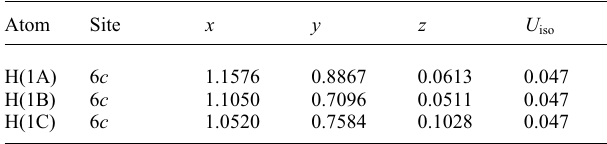
Table 2. Atomic coordinates and displacement parameters (in Å 2 ) .